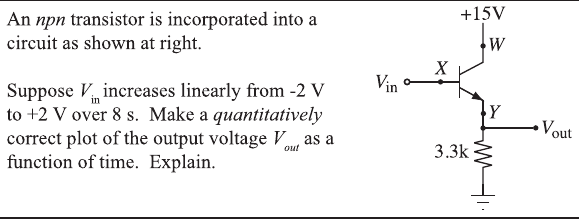
FIG. 5. Follower voltage graphing task. Note that students were provided with both a plot of V vs time and a labeled grid in in which to plot V vs time. out